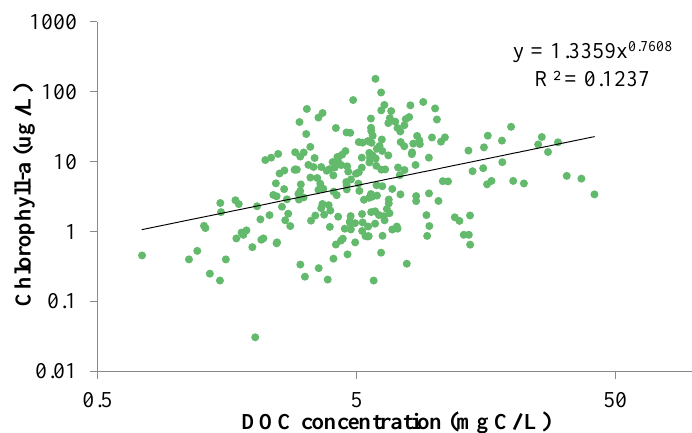
Figure 4. Scatter plot and linear regression between DOC concentration and chlorophyll-a.